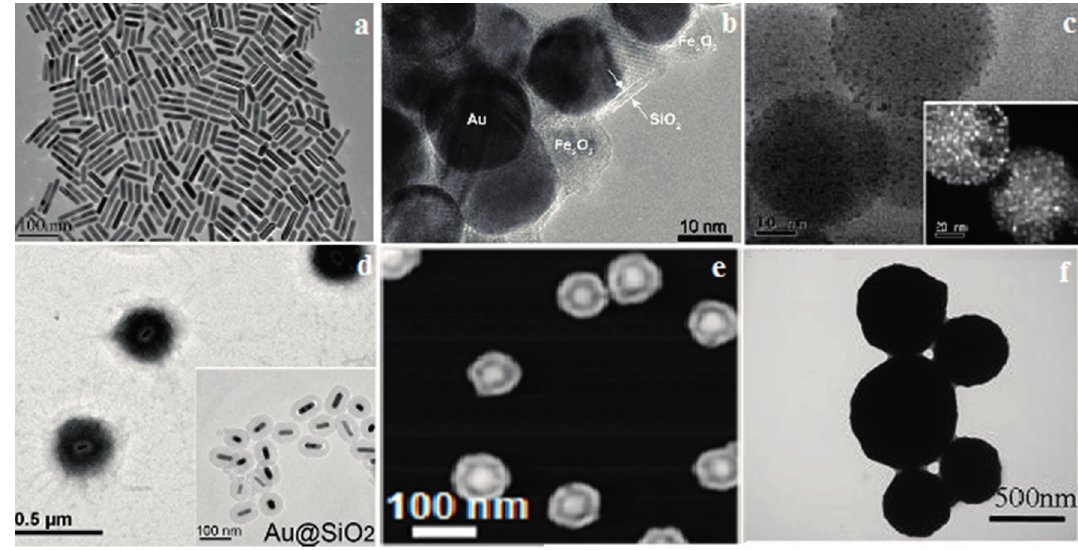
Figure 1. Morphology of Au-nanoparticles: ( a ) TEM image of Au-nanorods (GNRs) ( b ) High-resolution TEM image of Au/Fe 2 O 3 nanoparticles coated with amorphous SiO 2 shells, ( c ) TEM of GSS nanoparticles showing the speckled silica surface; inset z-contrast digital TEM, ( d ) TEM images of nanocomposite and Au@SiO 2 (inset) ( e ) SEM image of nanomatryoshkas and ( f ) TEM image of self-assembly structured Au-nanoparticles. (reproduced from [25] (a), [26] (b), [27] (c), [22] (d), [28] (e), [29] (f) with